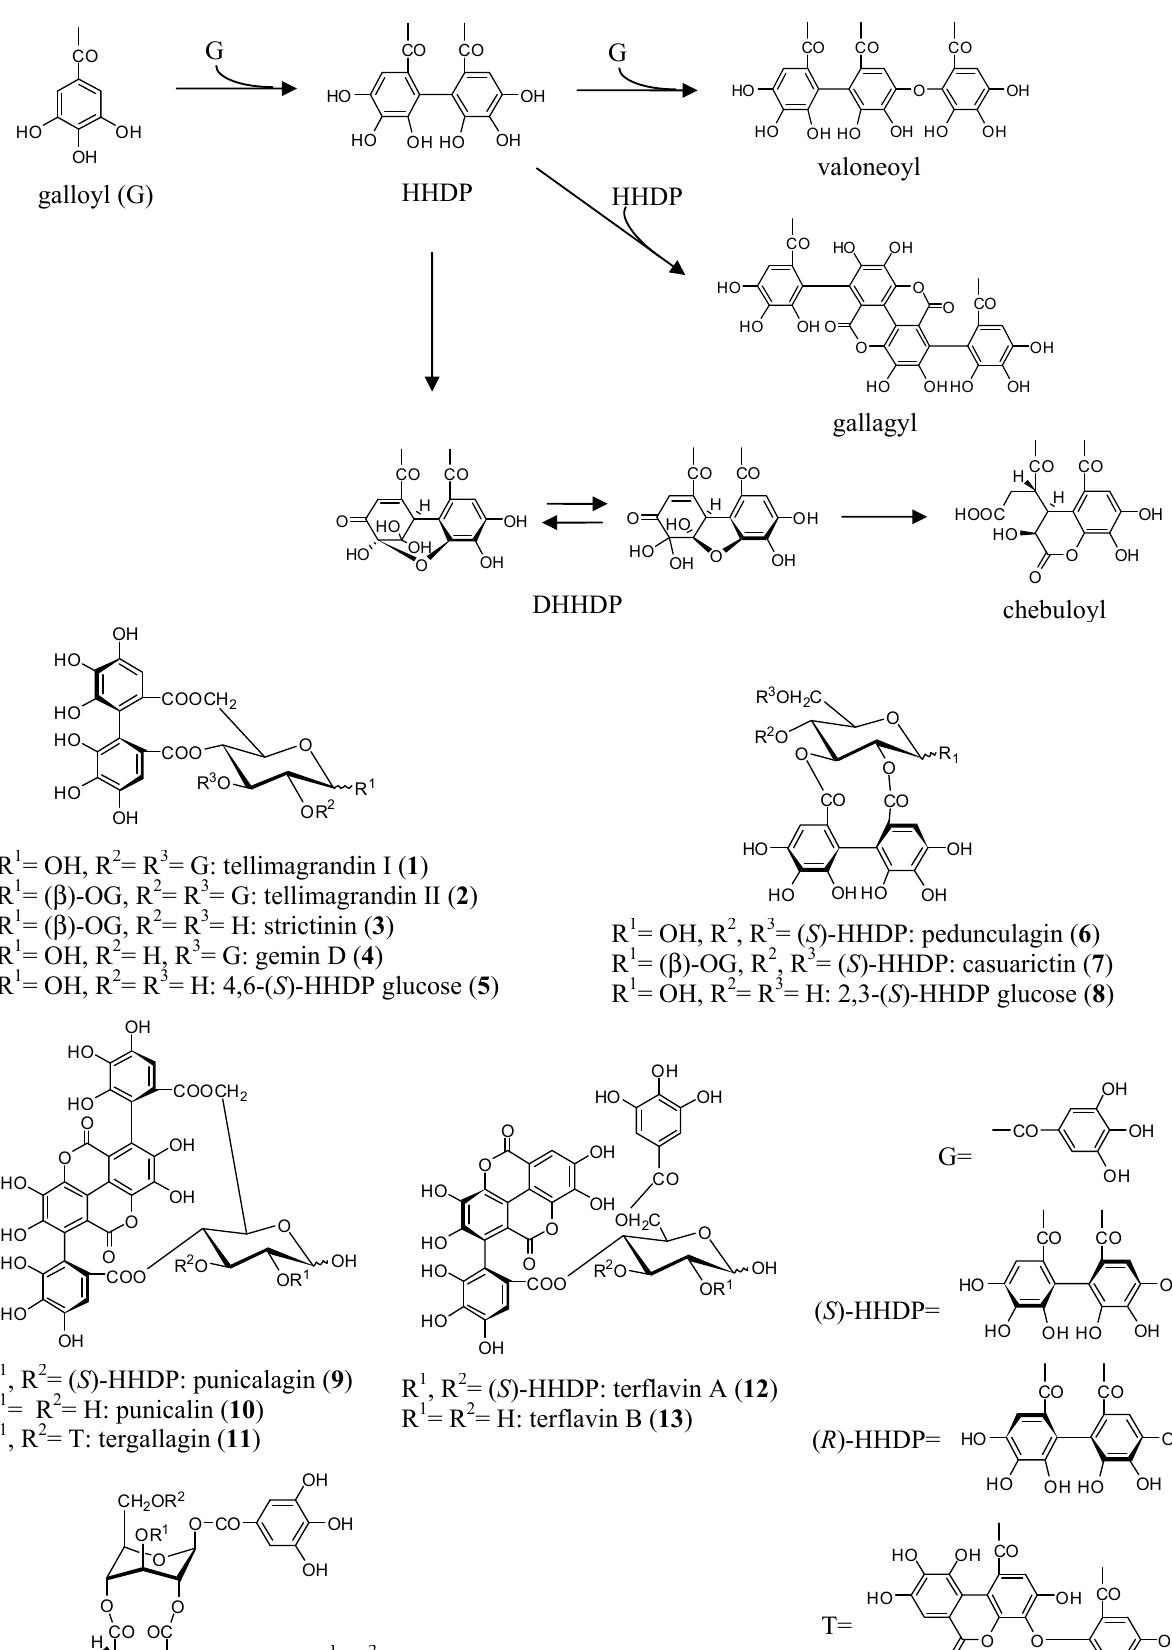
Figure 1. Structures of monomeric ellagitannins 1 – 15